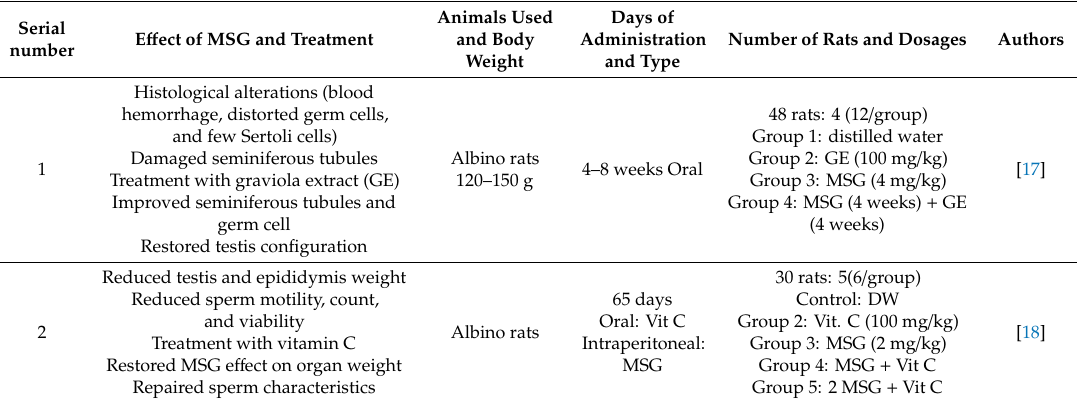
Table 2. Treatment options to ameliorate MSG-induced reproductive tissue